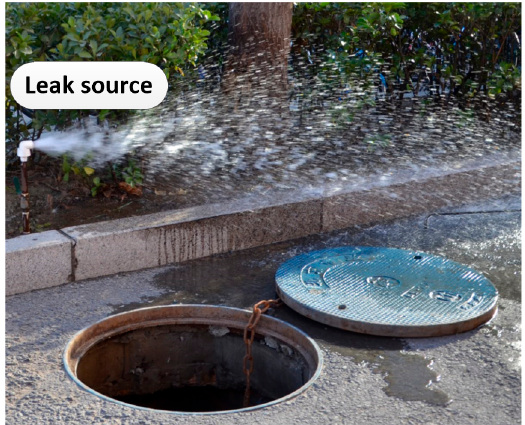
Figure 11. Leak generated above the ground.